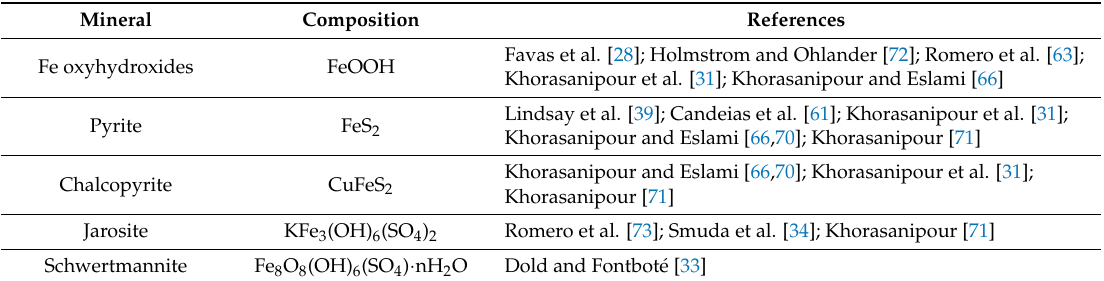
Table 6. Minerals in mine wastes containing Mo as a trace element. * Inferred from sequential extractions. Mineral